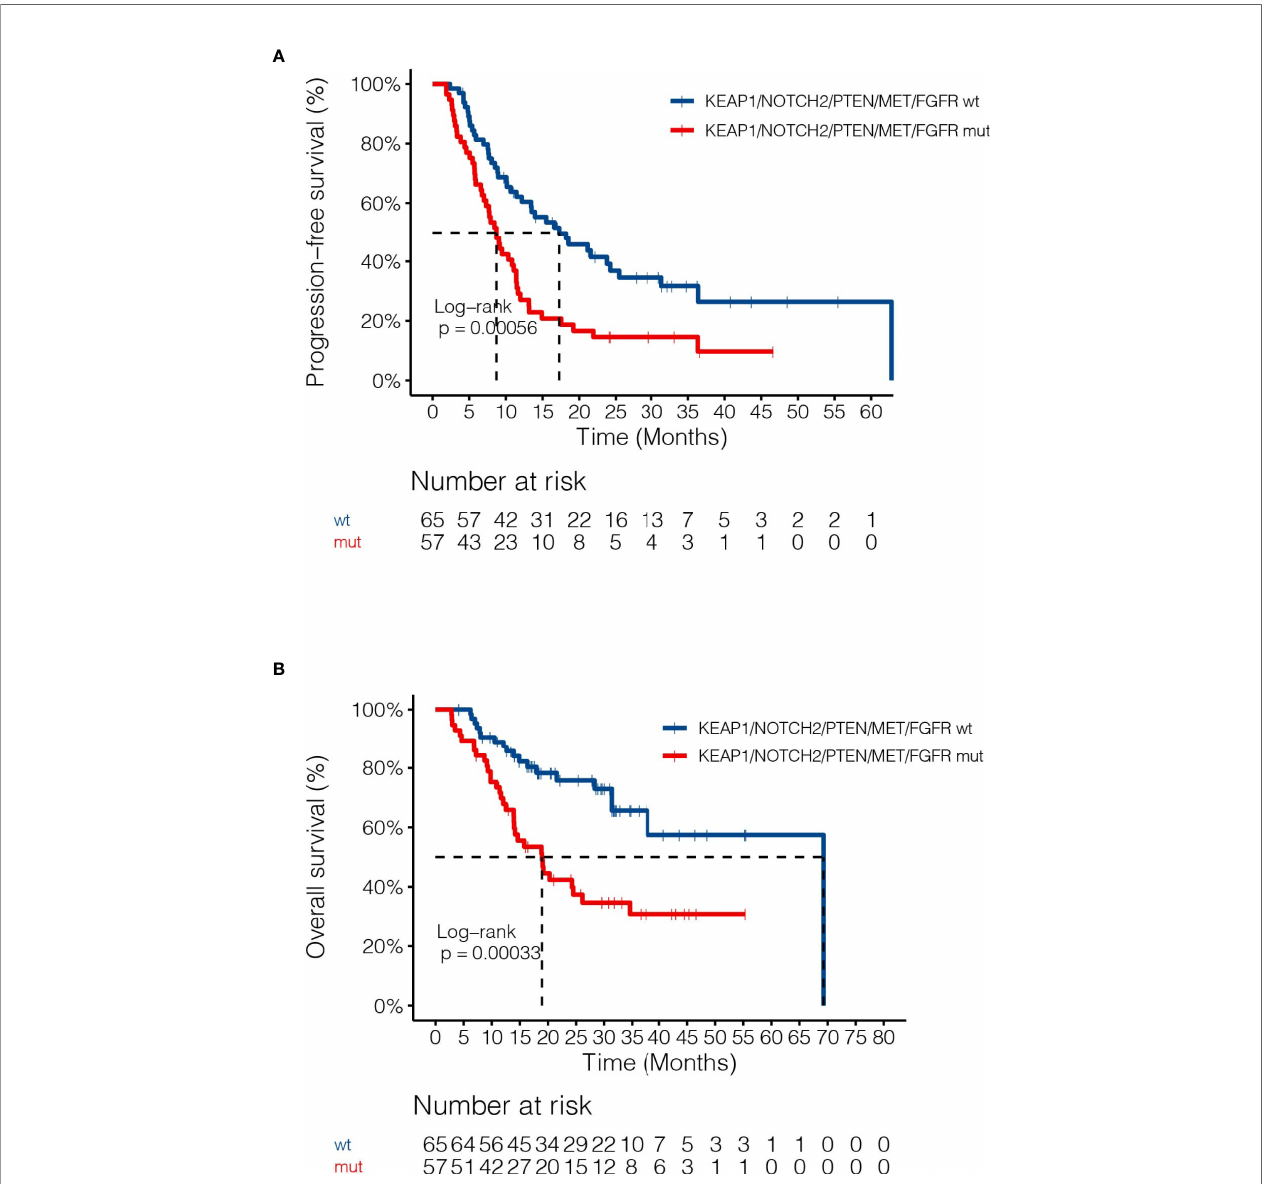
FIGURE 5 | Associations of dCRT survival outcomes with the mutant subgroup. (A, B) Kaplan-Meier estimates of (A) PFS and (B) OS in the full analysis set comparing patients harboring any of the MET , NOTCH2 and PTEN loss of function, as well as FGFR and KEAP1-NRF2 pathway gene alterations and those